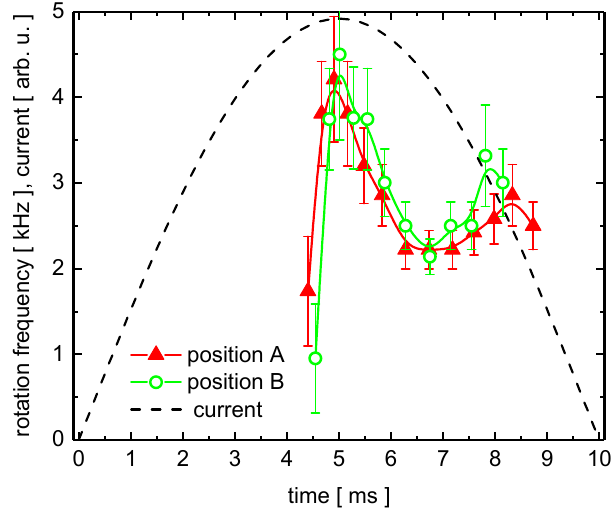
Figure 8. Rotation frequency of the arc determined from high-speed images. Red triangles—contact system of type A; green circles—those of type B. Arc current evolution is presented by dashed curve.